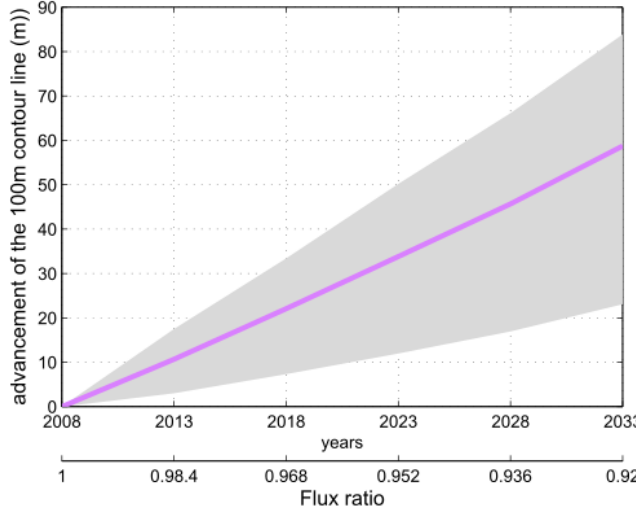
Figure 9. Advancement inland of the 100 m contour line of the seawater/freshwater interface with respect to flux ratio and years.